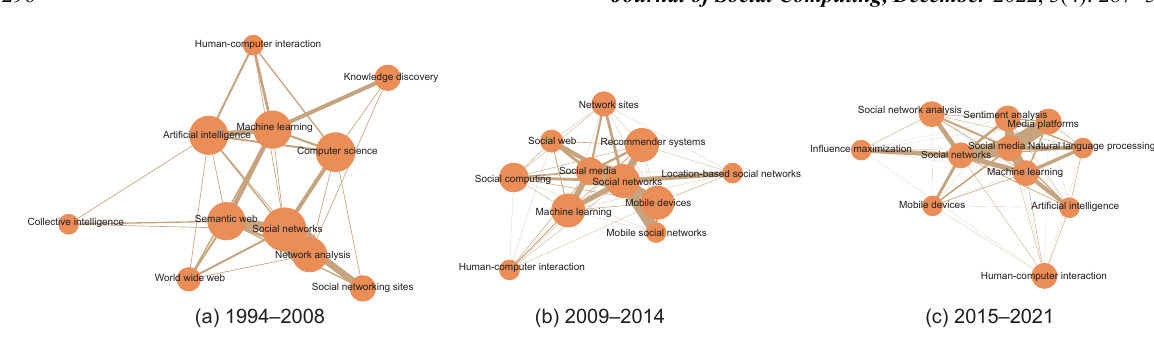
Fig. 7 Research topic network in different time stages. Table 8 Research topic pairs with the highest weights in different time